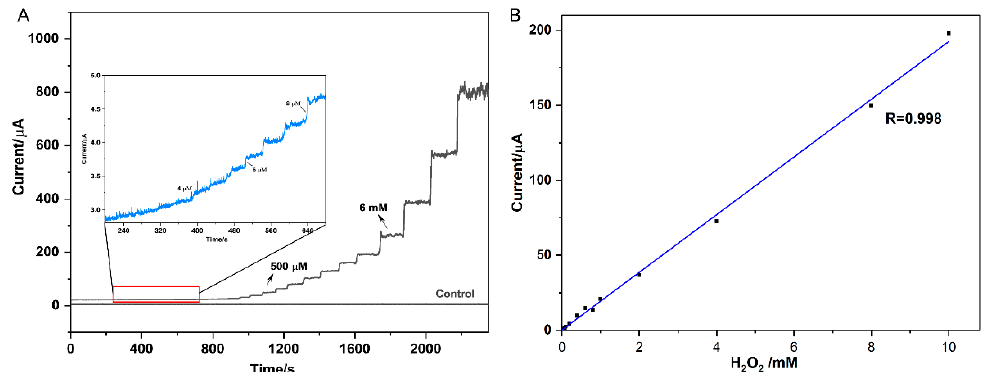
Figure 4. ( A ) Current–time (i − t) data and ( B ) calibration plot for H 2 O 2 for Ag-mSiO 2 / GC electrode. Inset in ( A ) shows current–time response for 4, 6, and 8 μ moL H 2 O 2 (arrows in black indicate point of aliquot additions) .